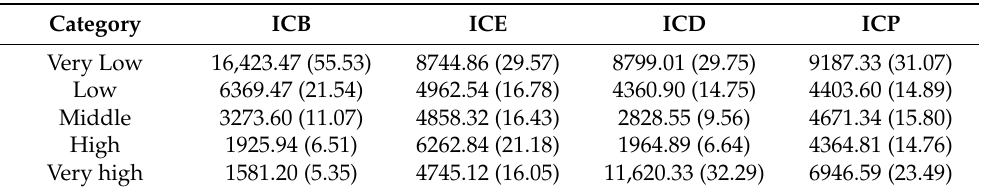
Table 4. Surface (ha) and percentage (%) of Potential Behaviour Biomass Index (ICB), Potential Behaviour Structural Complexity Index (ICE), Potential Behaviour Fuel Desiccation Index (ICD), and Potential Fire Behaviour Index (ICP) of forest types in Sierra de las Nieves National Park (M á laga, southern